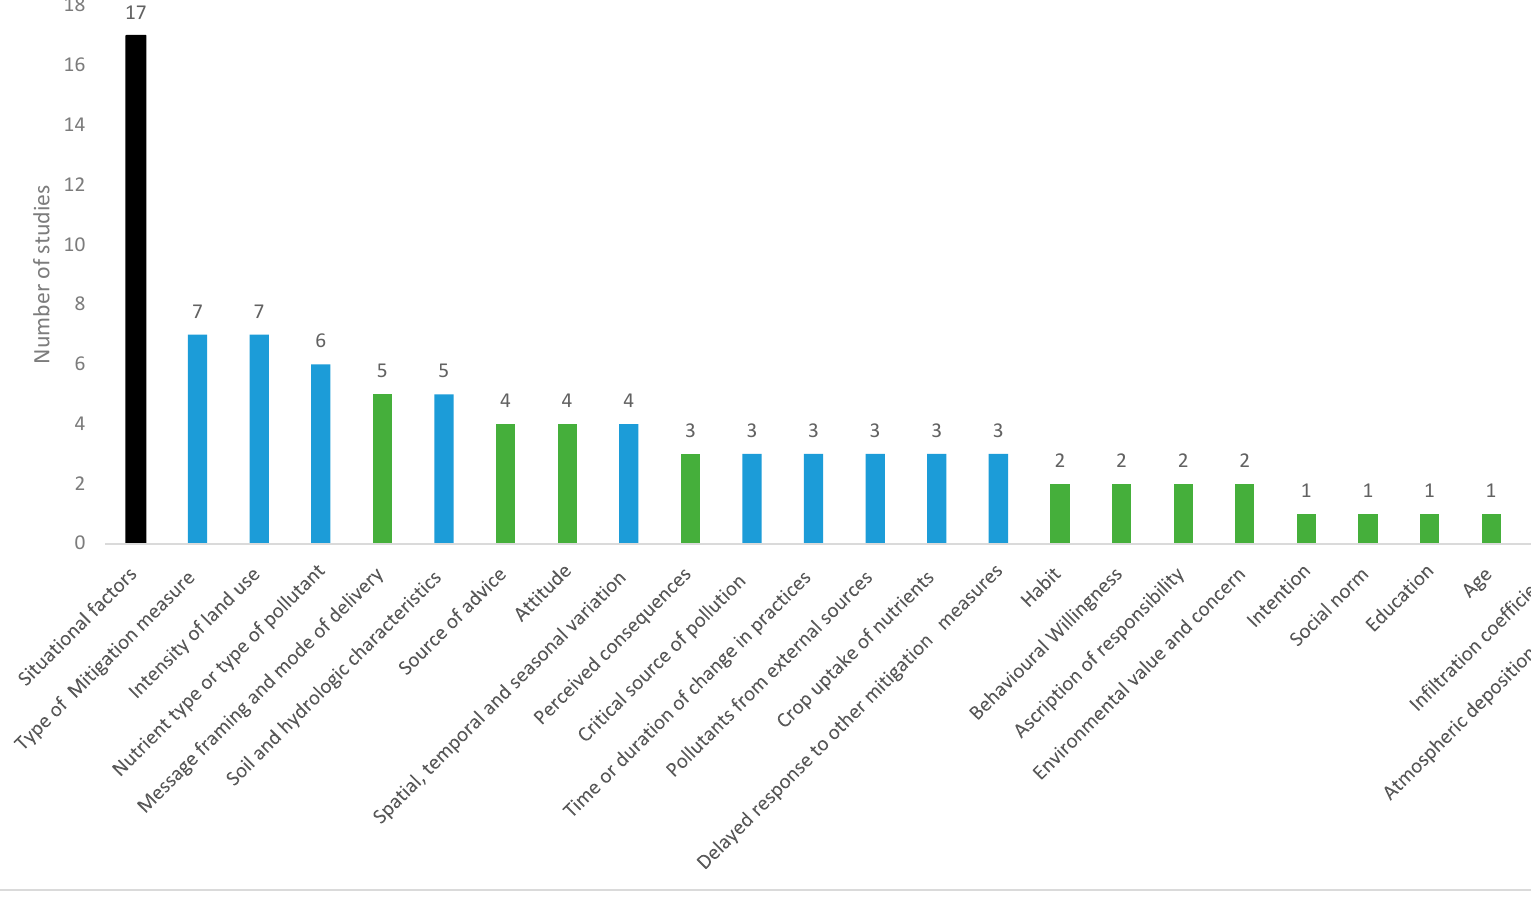
Figure 1. Summary of variables affecting the awareness–behavioural change–water quality pathway. Note: Green = factors directly affecting awareness and behaviour; Blue = factors directly affecting water quality; Black = factor affecting awareness, behaviour and water quality.